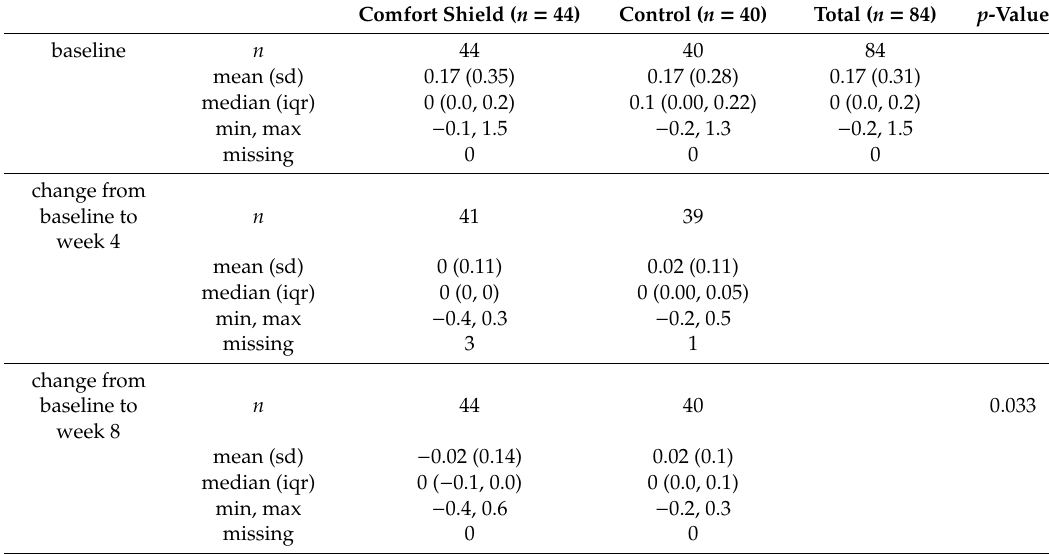
Table 11. BCVA: value at baseline and change from baseline to each post-baseline visit—PPS ( n = 84)—descriptive analysis, by treatment